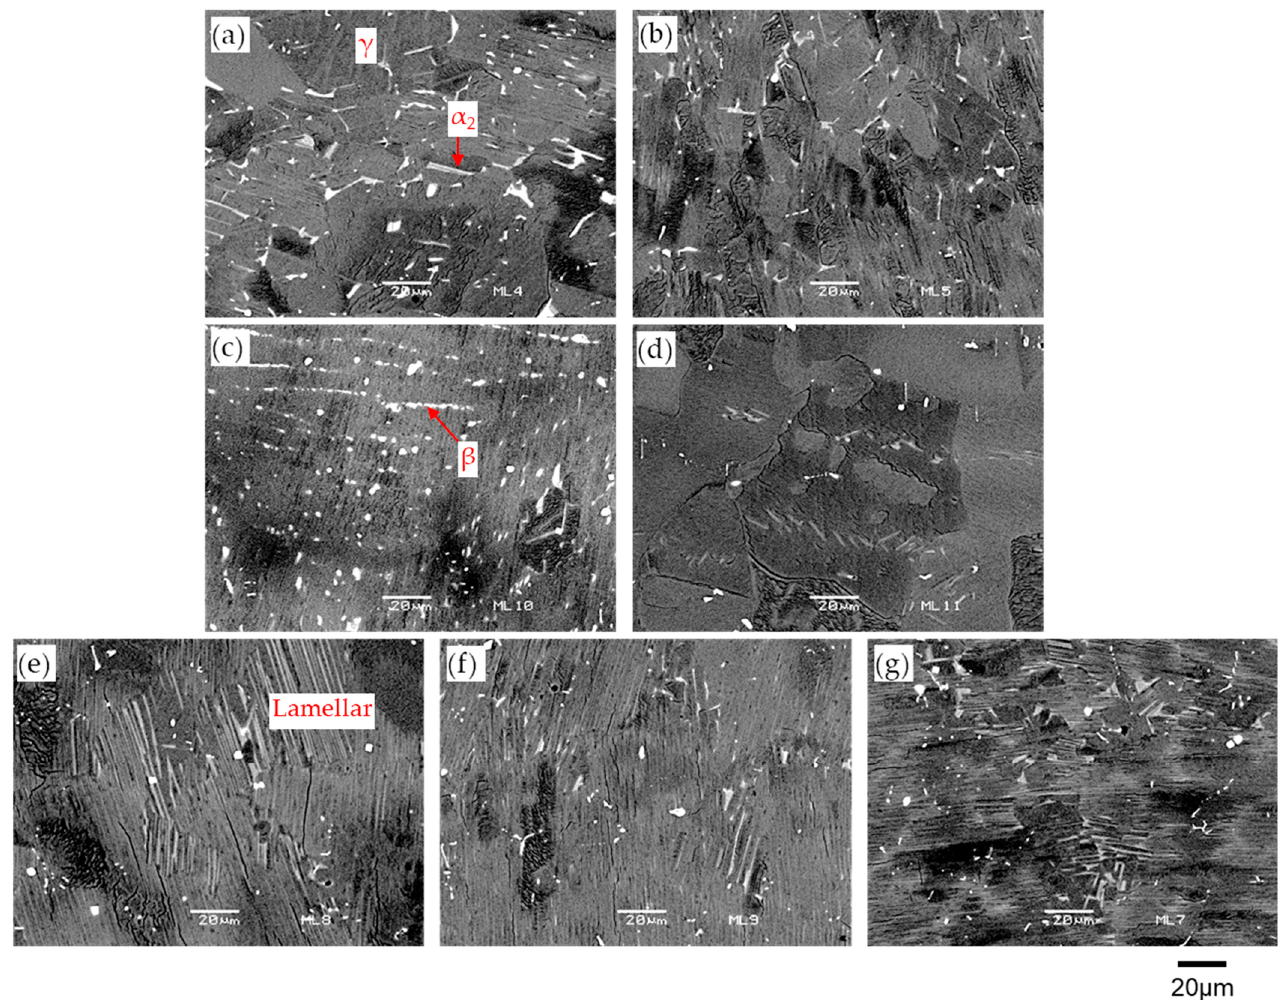
Figure 3. Backscattered electron images showing the microstructure of the TiAl cast alloys after heat treatment at 1200 °C for 4 h, followed by cooling at 10 °C/min: ( a ) TiAl4822, ( b ) 47XD, ( c ) TNB-V2, ( d ) RNT650, ( e ) Ti-46.5Al, ( f ) Ti-46.5Al-1.6Cr, and ( g ) Ti-46.5Al-4.0V.